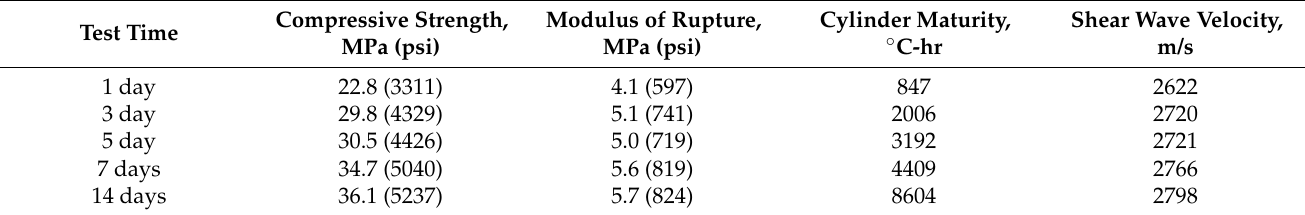
Table 1. Test pavement